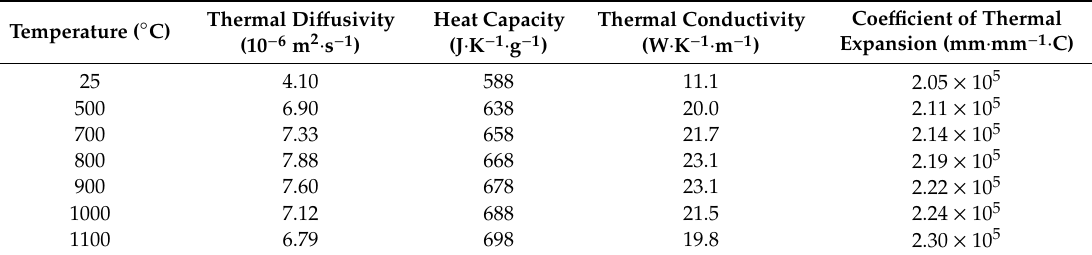
Table 2. Thermophysical parameters of high Nb–TiAl alloy, data from